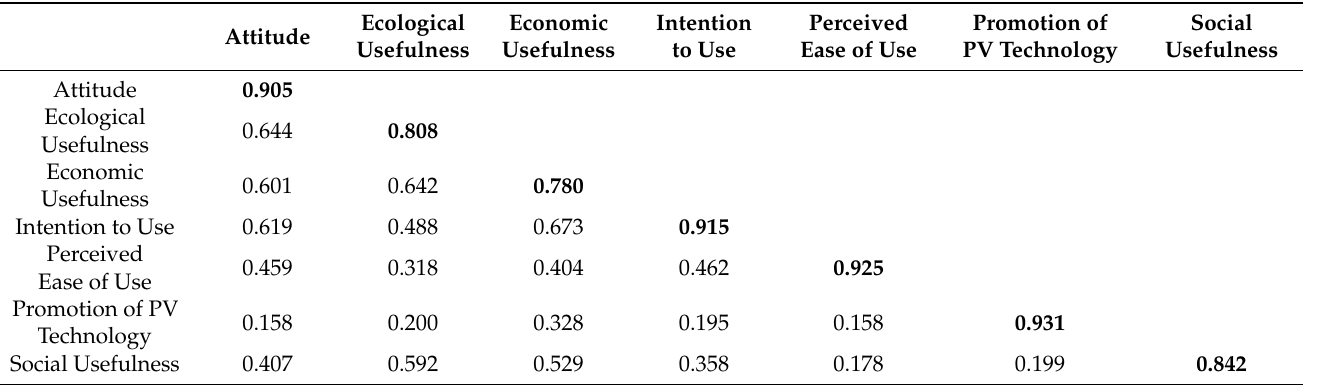
Table 3. Discriminant Validity (Fornell–Larcker